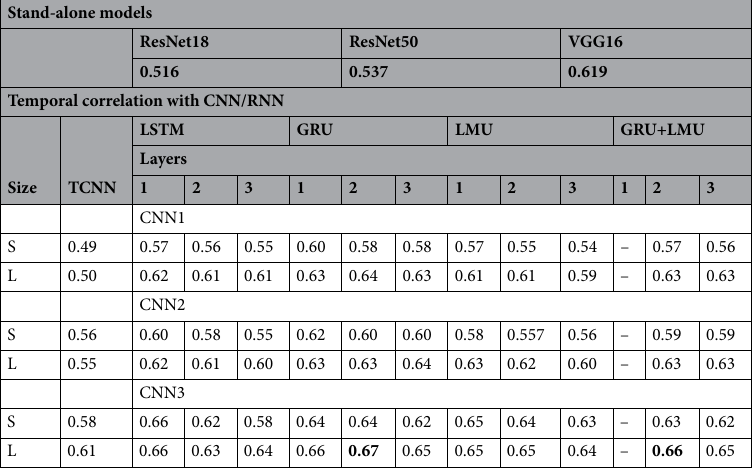
Table 1. Test accuracy comparison on the CBC2020 dataset. Top : Models without any explicit temporal layer. The input is a single spectrogram from a sound sample. Bottom : A comprehensive comparison of models’ test accuracy using CNN/RNN for temporal correlation. The complexity of the CNN used for representation increases from top to bottom. The best accuracy achieved is shown in bold. For each representation CNN*, a small width (S) and a large width (L) temporal layer is shown. For RNNs the S/L refer to the hidden layer size of 128/512, while for TCNN S/L refers to TCNN1/TCNN3.